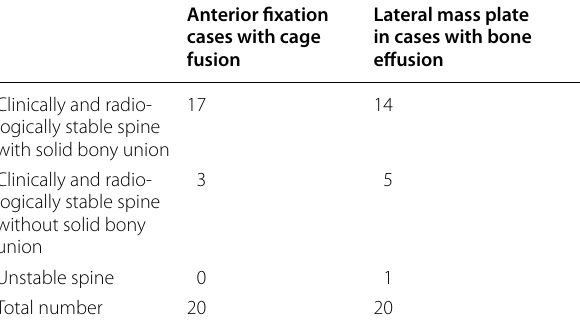
Table 4 Achievement of stability and bony union in